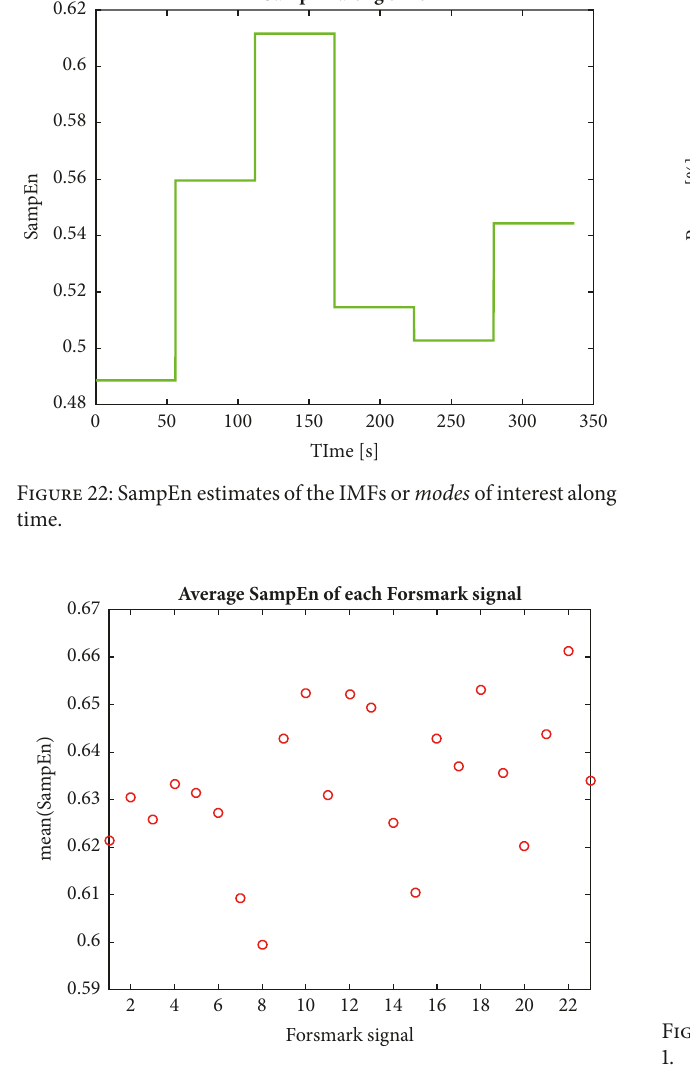
Figure 23: Computed mean(SampEn) of the studied 23 unstable signals (SampEn of the IMFs linked to instability) of the studied Forsmark Case 4.